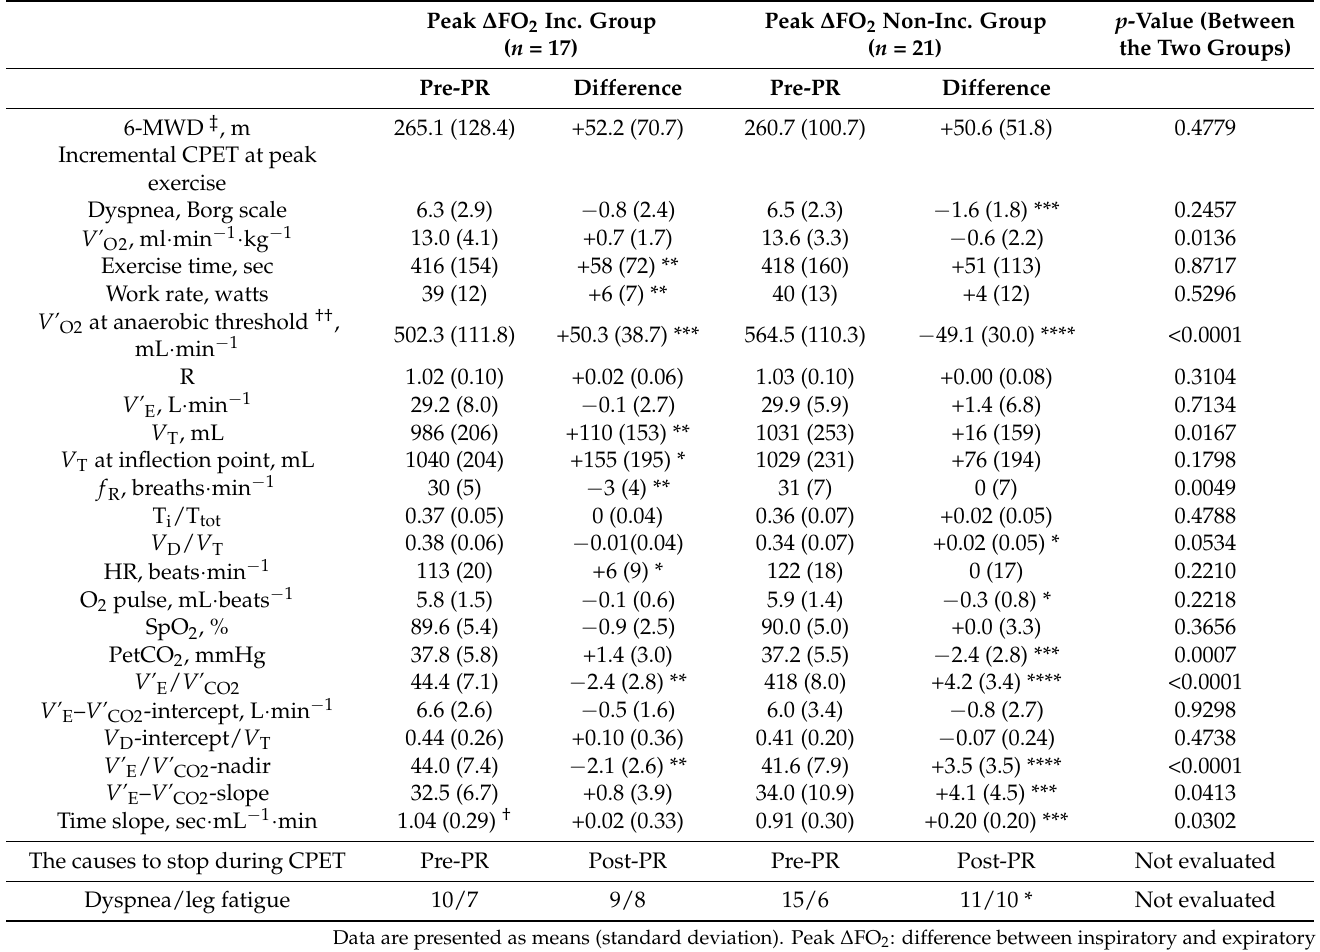
Table 4. Changes in the results of exercise testing after pulmonary rehabilitation in the peak ∆ FO 2 increase and non-increase groups. Peak ∆ FO 2 Inc. Group Peak ∆ FO 2 Non-Inc. Group